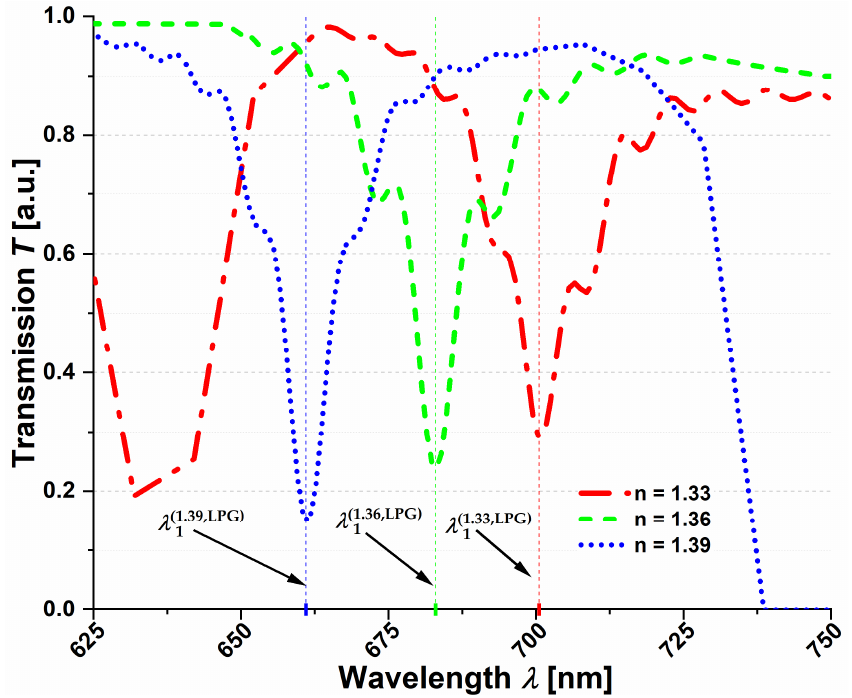
Figure 4. Transmission windows of the NCHCF-based LPG for 3 consecutive values of the